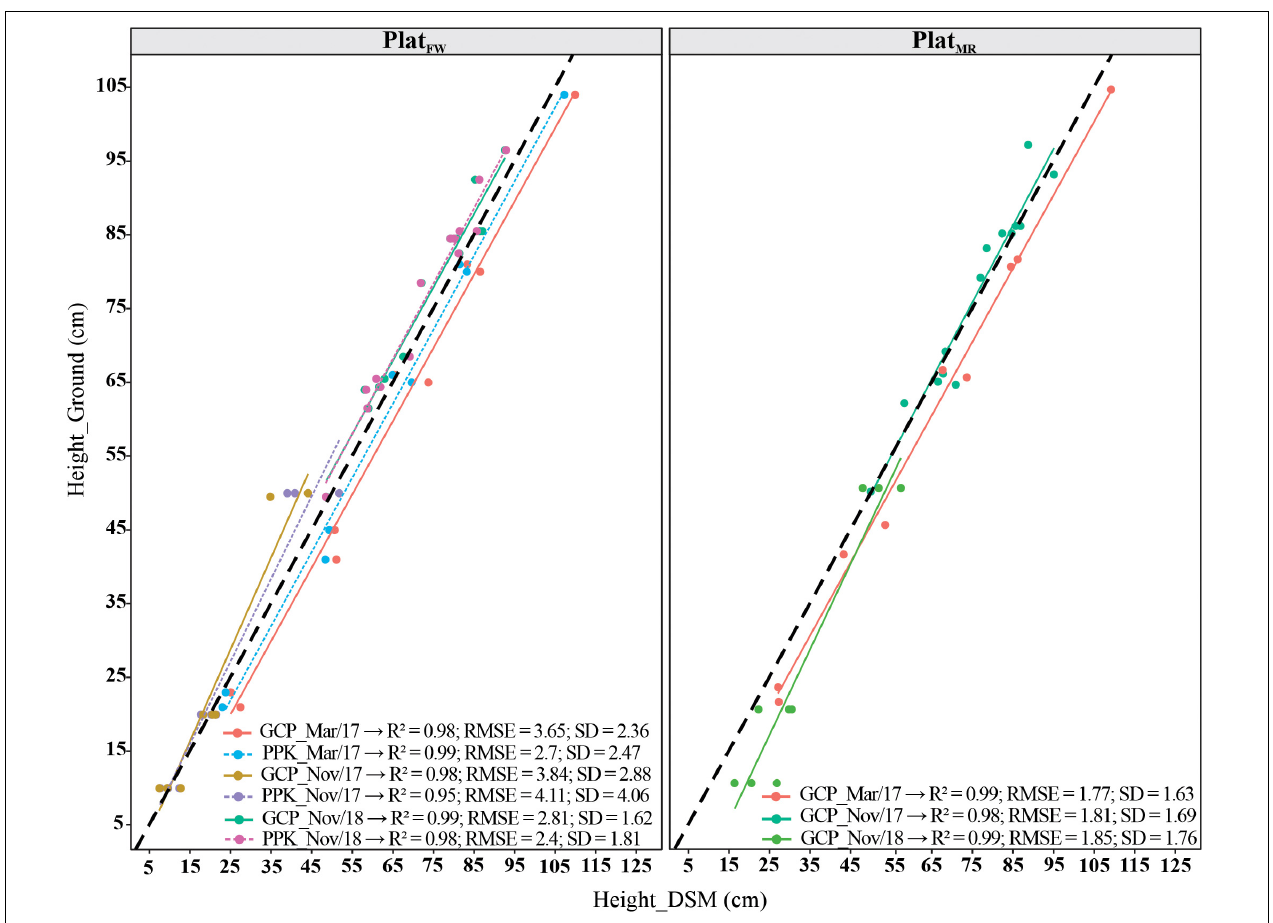
FIGURE 3 | Coefficient of determination ( R 2 ), root mean square deviation (RMSE), and standard deviation (SD) of the errors, between ground control points (GCPs) height estimate from the digital surface model (DSM), and ground-truth measurements for three different dates of flights using PPK for fixed-wind platform ( Plat FW ) and only GCP corrections for Plat FW and multi-rotor ( Plat MR ). The dark black dashed diagonals represent the 1:1 line, and the colored solid (GCP) and dashed (PPK) lines represent the regression